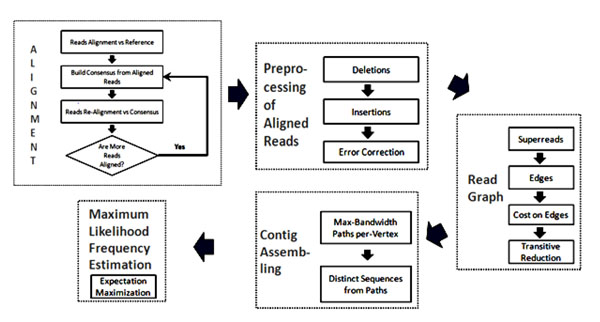
ViSpA’s flowchart.